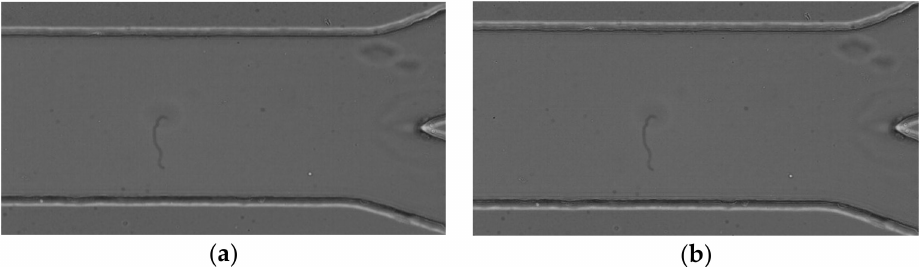
Figure 10. ( a ) The obtained image by applying the projection average intensity and ( b ) the obtained image by applying the projection sum slices.